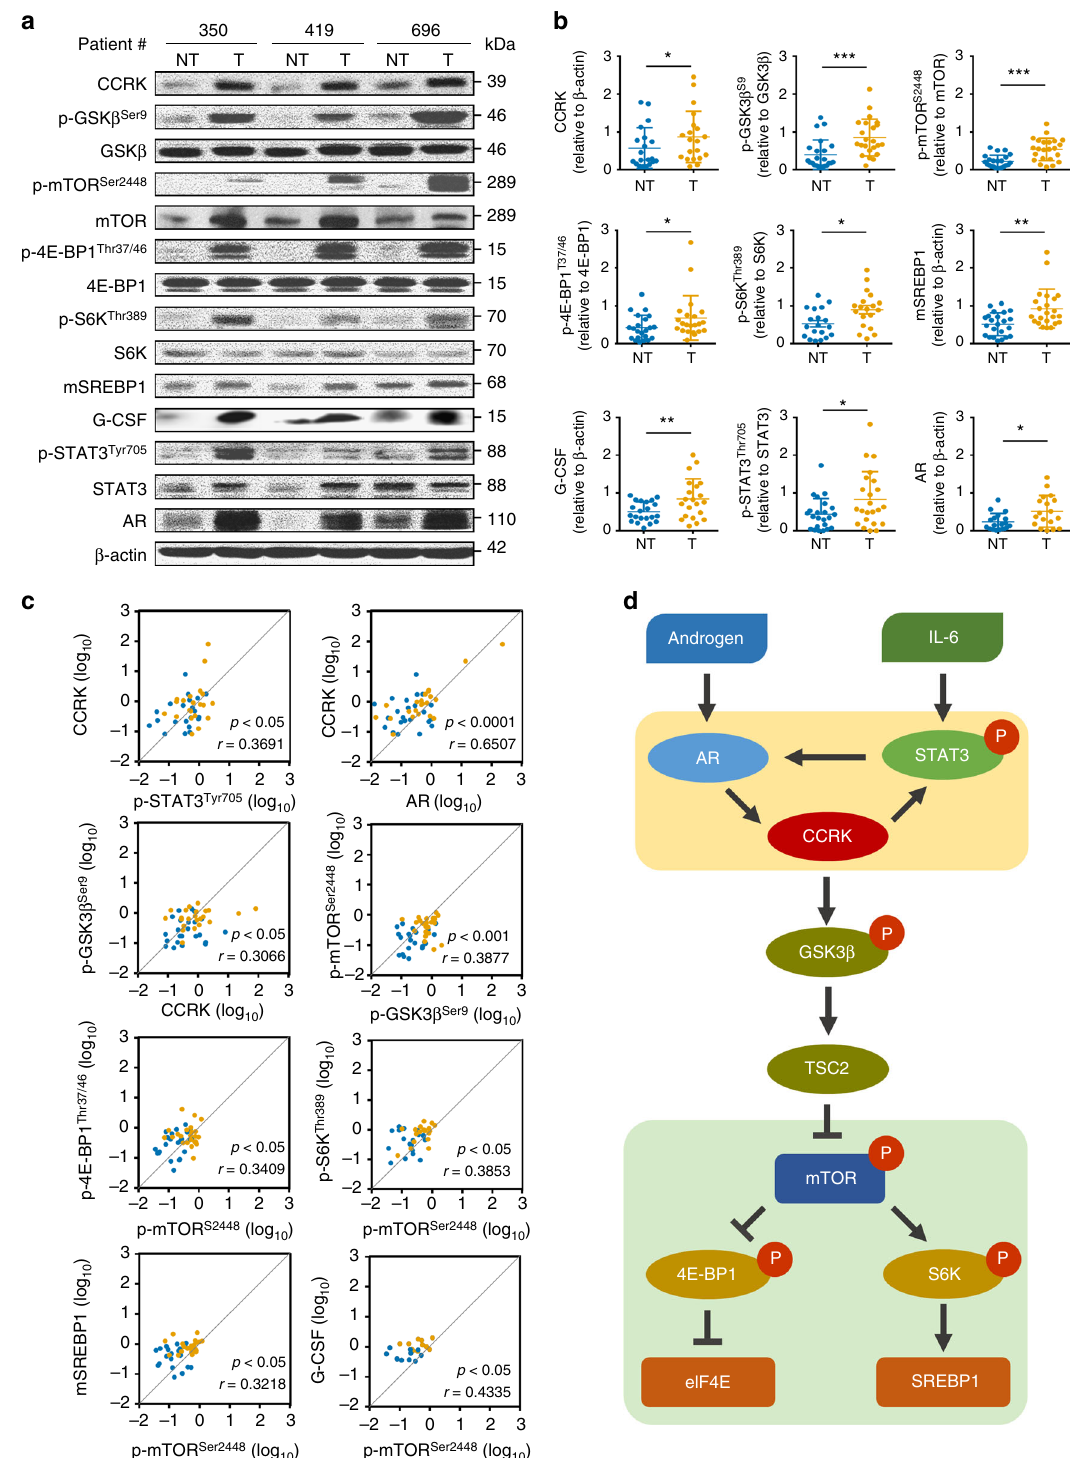
Fig. 7 CCRK over-expression correlates with mTOR signaling activation in patients with NASH-associated HCCs. a Western blots showed the induced expressions of CCRK/mTOR signaling proteins in HCC tissues relative to matched non-tumor tissues (23 pairs), and representative results from three patients are shown. b The Western blot results of all patients from a were quanti fi ed and shown in dot plots, wherein the fold enrichments of target proteins relative to their corresponding controls are shown. c The positive correlations of STAT3/AR/CCRK/GSK3 β /mTORC1 signaling components were con fi rmed in the patient specimens. d Schematic diagram showing the IL-6-triggered self-reinforcing circuitry of STAT3/AR/CCRK (highlighted in the yellow panel), which activates mTORC1 signaling (highlighted in the green panel) through GSK3 β /TSC2 to promote NASH and HCC development. Data are presented as mean ± SD. * p < 0.05; ** p < 0.01; *** p < 0.001 as calculated by unpaired two-tailed Student ’ s t -test ( b ), and Pearson correlation ( c